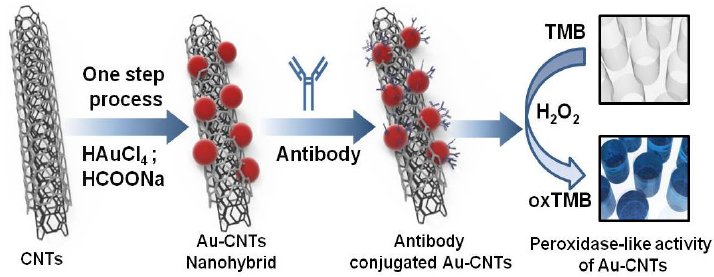
Figure 21. Colorimetric detection of influenza A (H3N2) virus in human serum